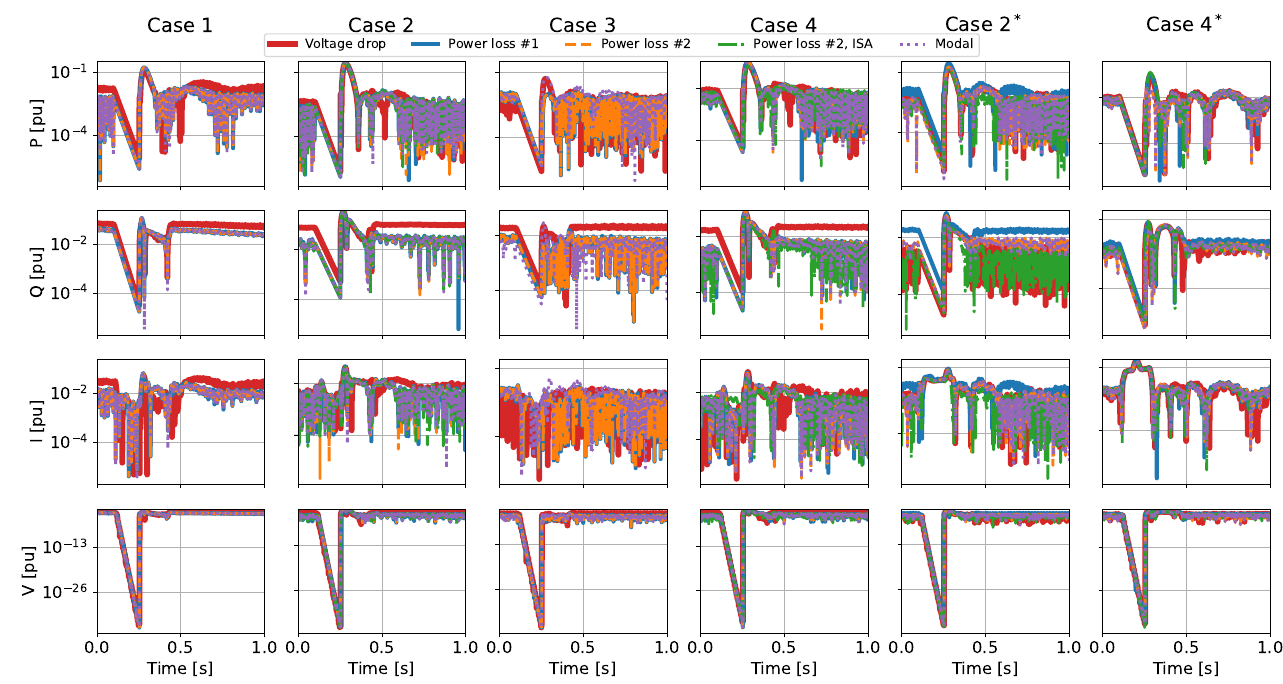
Figure A2. Errors plotted in log-scale from time-domain simulation results for all case studies with respect to the detailed equivalent of the case